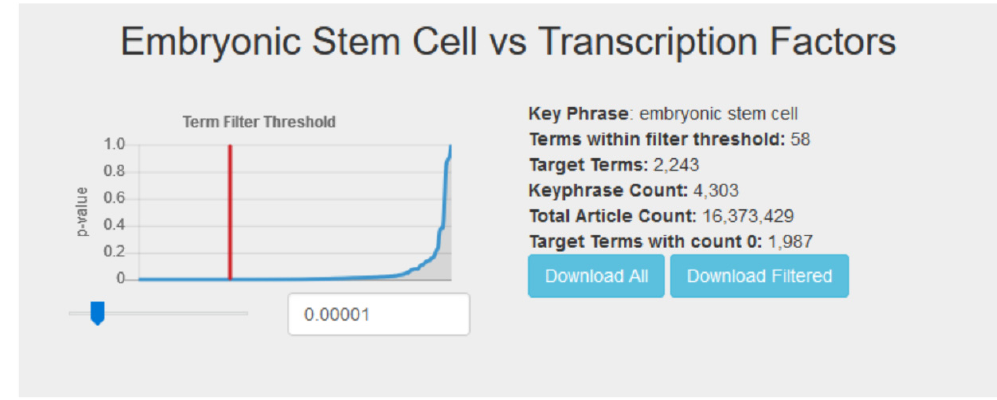
Figure 3. Users can dynamically filter the results for a query using the p-value